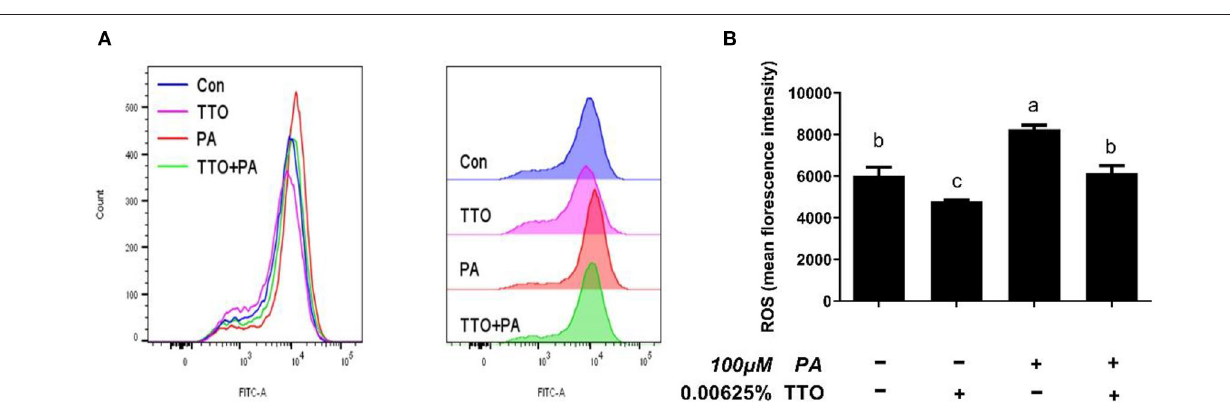
FIGURE 6 | The effect of TTO on ROS production. (A) ROS levels in bovine hepatocytes treated with TTO (0.00625%) and/or PA (100 µ M). Cellular ROS generation following different treatments was measured by staining with DCFH-DA. The fluorescence was detected using flow cytometry. (B) Cellular ROS level. All results are expressed as the mean ± SEM. The letters above the error bars indicate that the difference between groups was significant ( P < 0.05). These data are representative of three independent